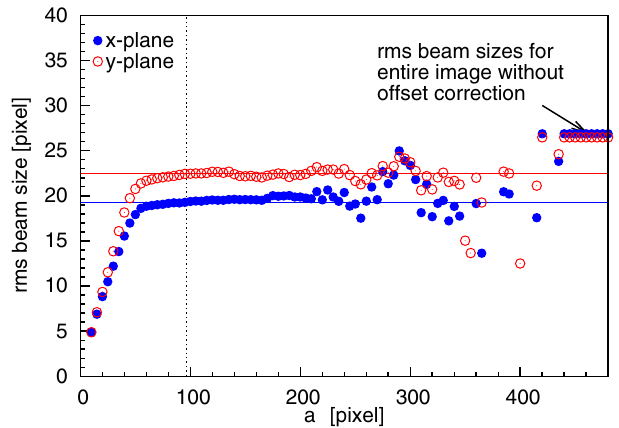
FIG. 2. (Color) Dependence of the reconstructed beam sizes on the size of the region of interest. Plotted is the horizontal semi- (see text). The dotted line shows the horizontal semiaxis axis a x a of the ellipse resulting from the algorithm used for the x analysis of the beam